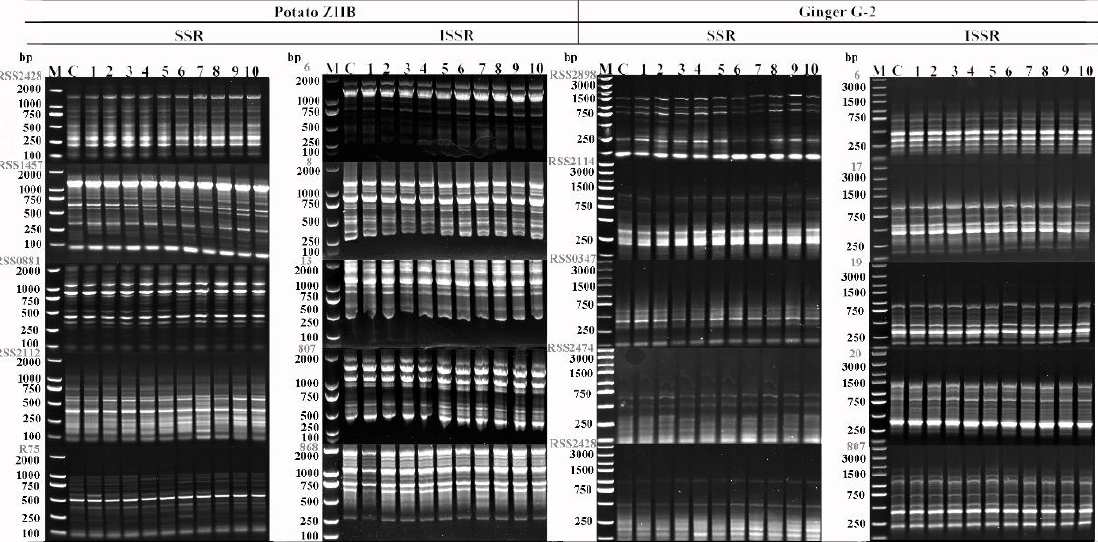
Figure 7. SSR and ISSR banding patterns in recovered potato ZHB and ginger G-2. Three repeats of 10 randomly selected samples were detected. 10 randomly selected samples were detected.